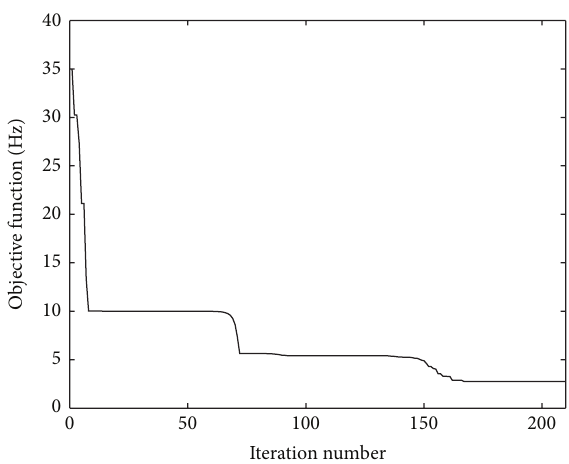
Figure 4: Convergence chart of the objective function.